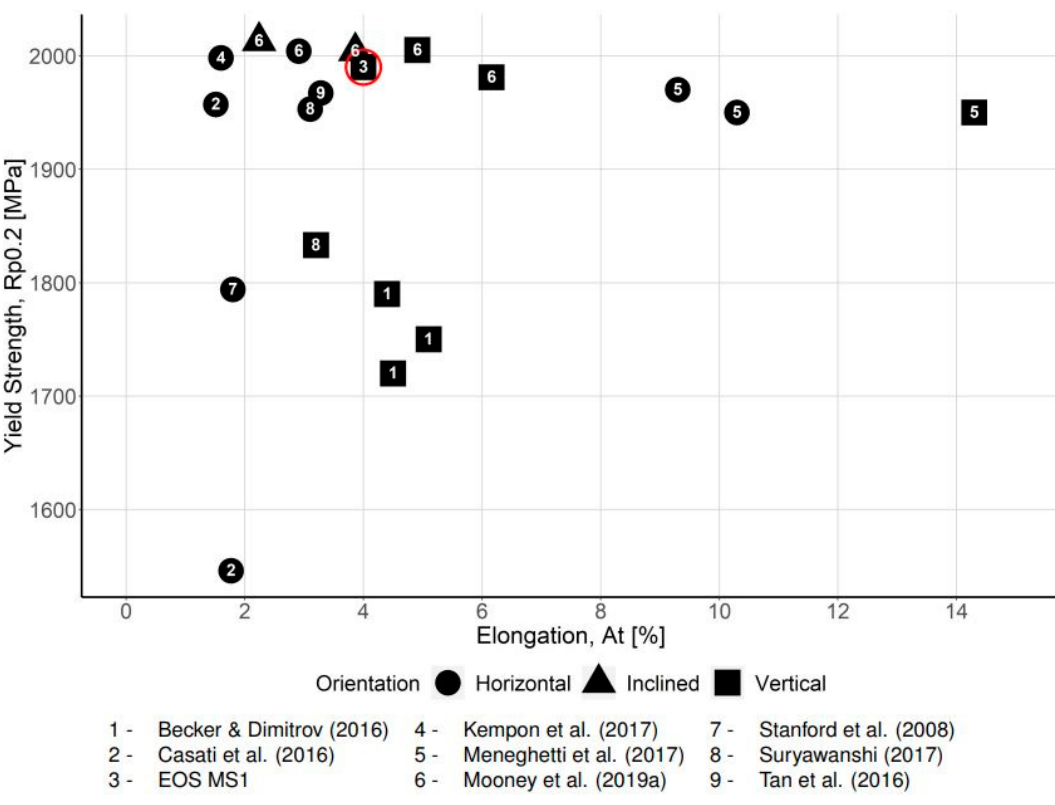
Figure 7. Comparison of the heat-treated (aged), for optimal strength, yield strength (Rp0.2) and % elongation (At) properties by AM build-orientation for maraging steel 300 test-specimens fabricated using various geometries, processing parameters, scan strategies, and powder feedstock types. Circled in red are the values published by EOS in their material datasheet for MS1 which indicate isotropic mechanical properties upon ageing since horizontal (circular symbol) and vertically orientated (triangular symbol) specimen values overlap.